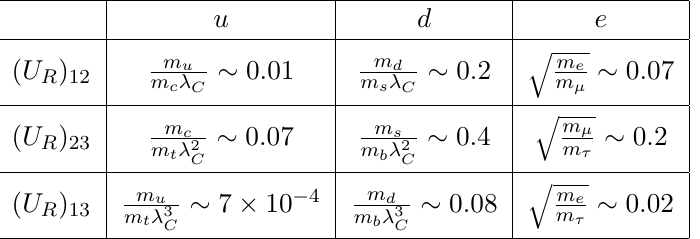
Table 1 . Estimates of coefficients of unitary Right-handed matrices using partial compositeness, taking the masses at the TeV